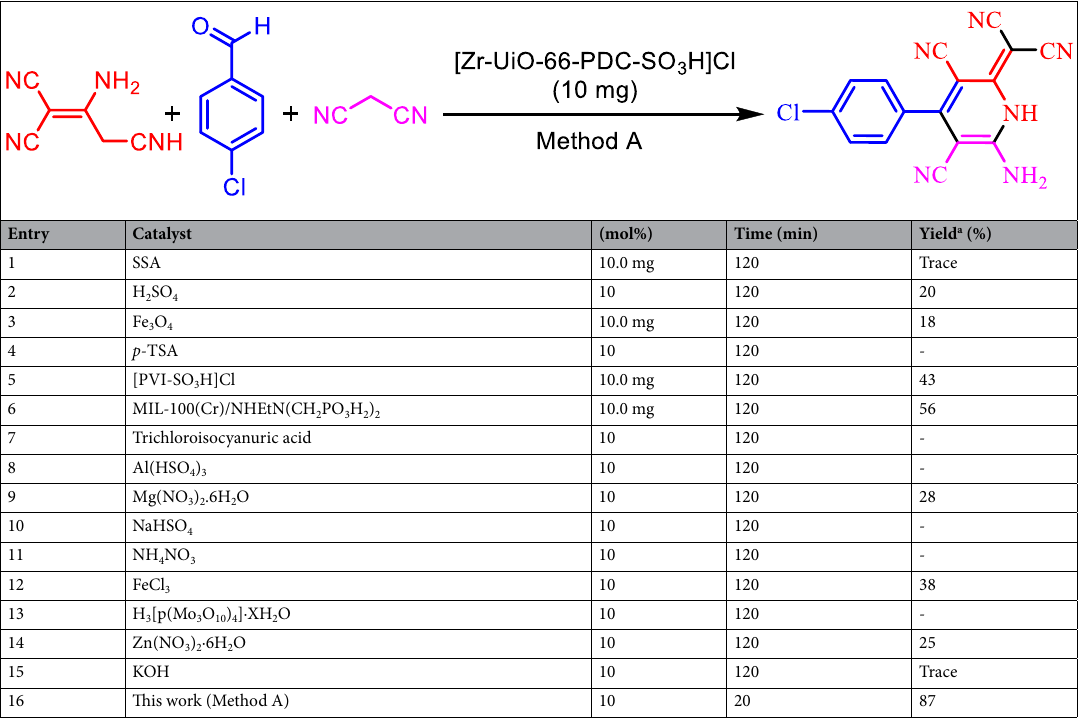
Table 5. Evaluation of various catalysts for the synthesis of dicyanomethylene pyridine in comparison with [Zr-UiO-66-PDC-SO 3 H]Cl. a Isolated